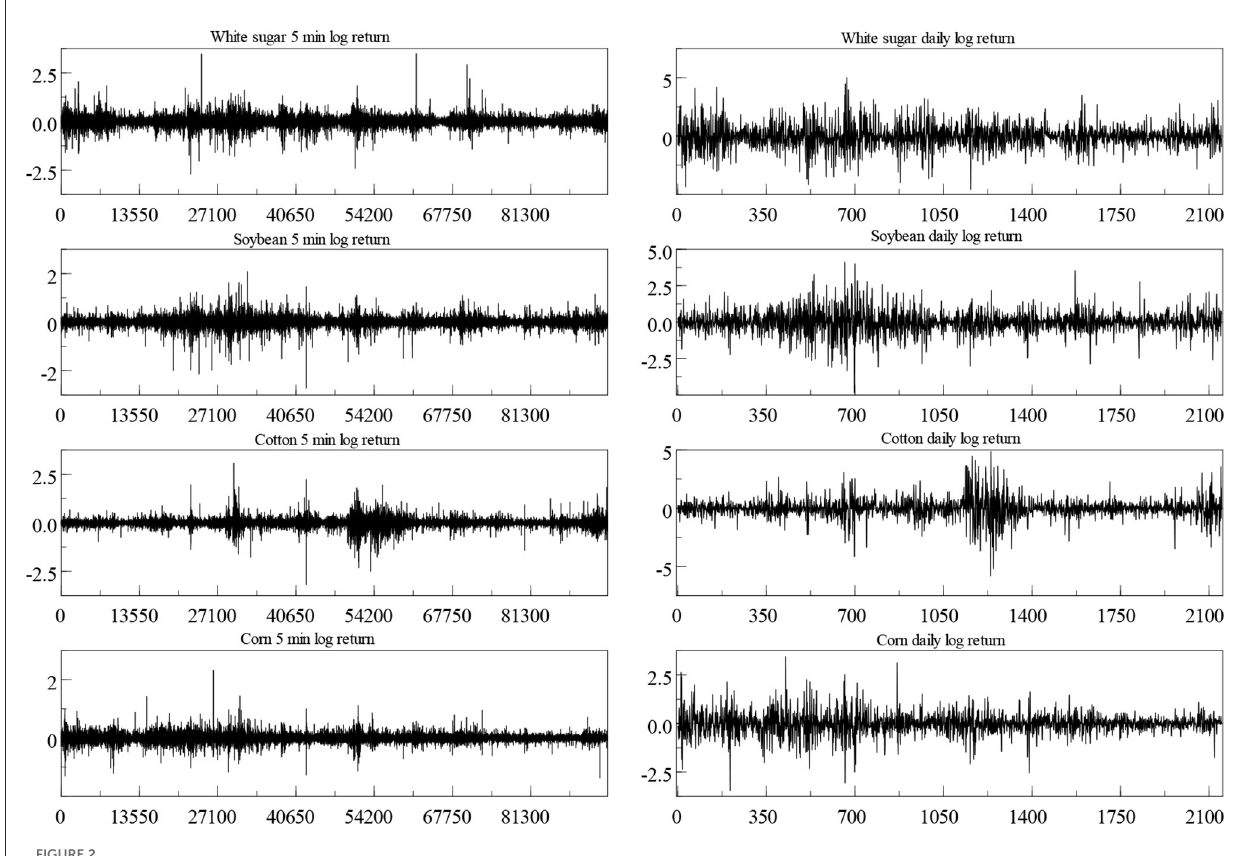
FIGURE2 Return series of four agricultural commodity futures.